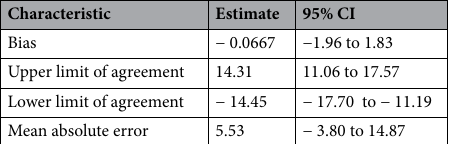
Table 5. Comparison between transcutaneous and intravesical methods: Bland-Altman analysis and mean absolute